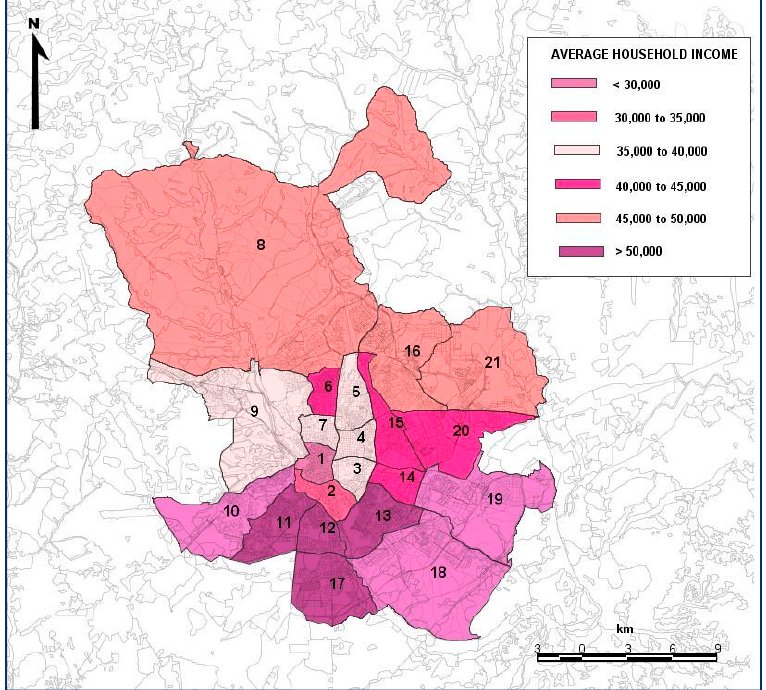
Figure 3. Average household income in the districts of Madrid analyzed in the period 2013–2019. Figure